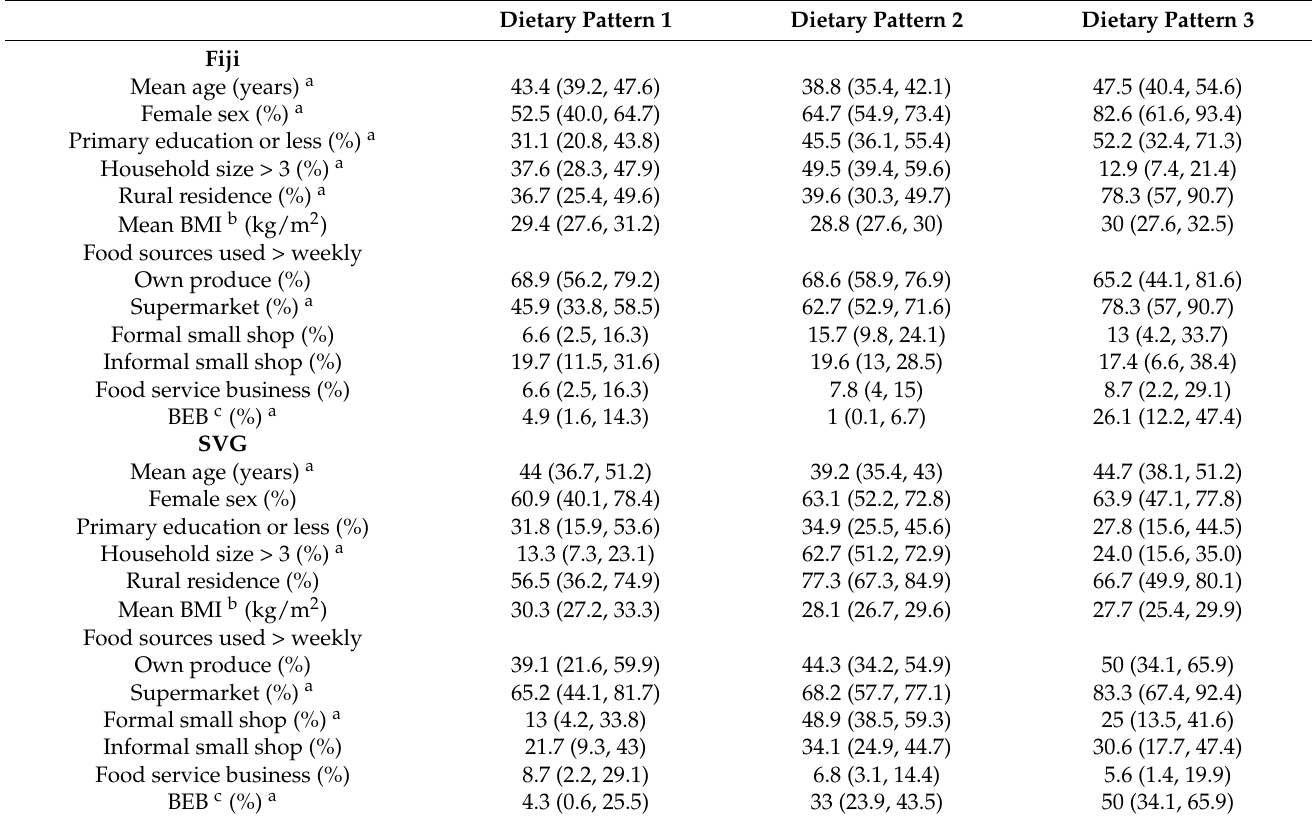
Table 3. Examination of associations between dietary patterns, socio-demographic, anthropometric and food source variables. Figures are means or percentages (95% CIs).